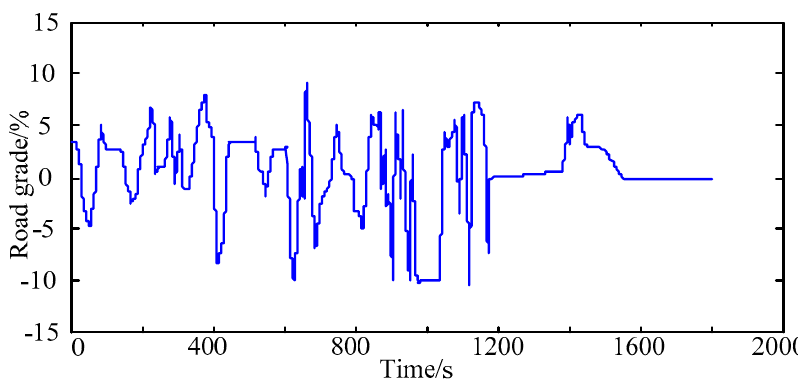
Figure 5. Added information of road grade in WLTP driving cycle.